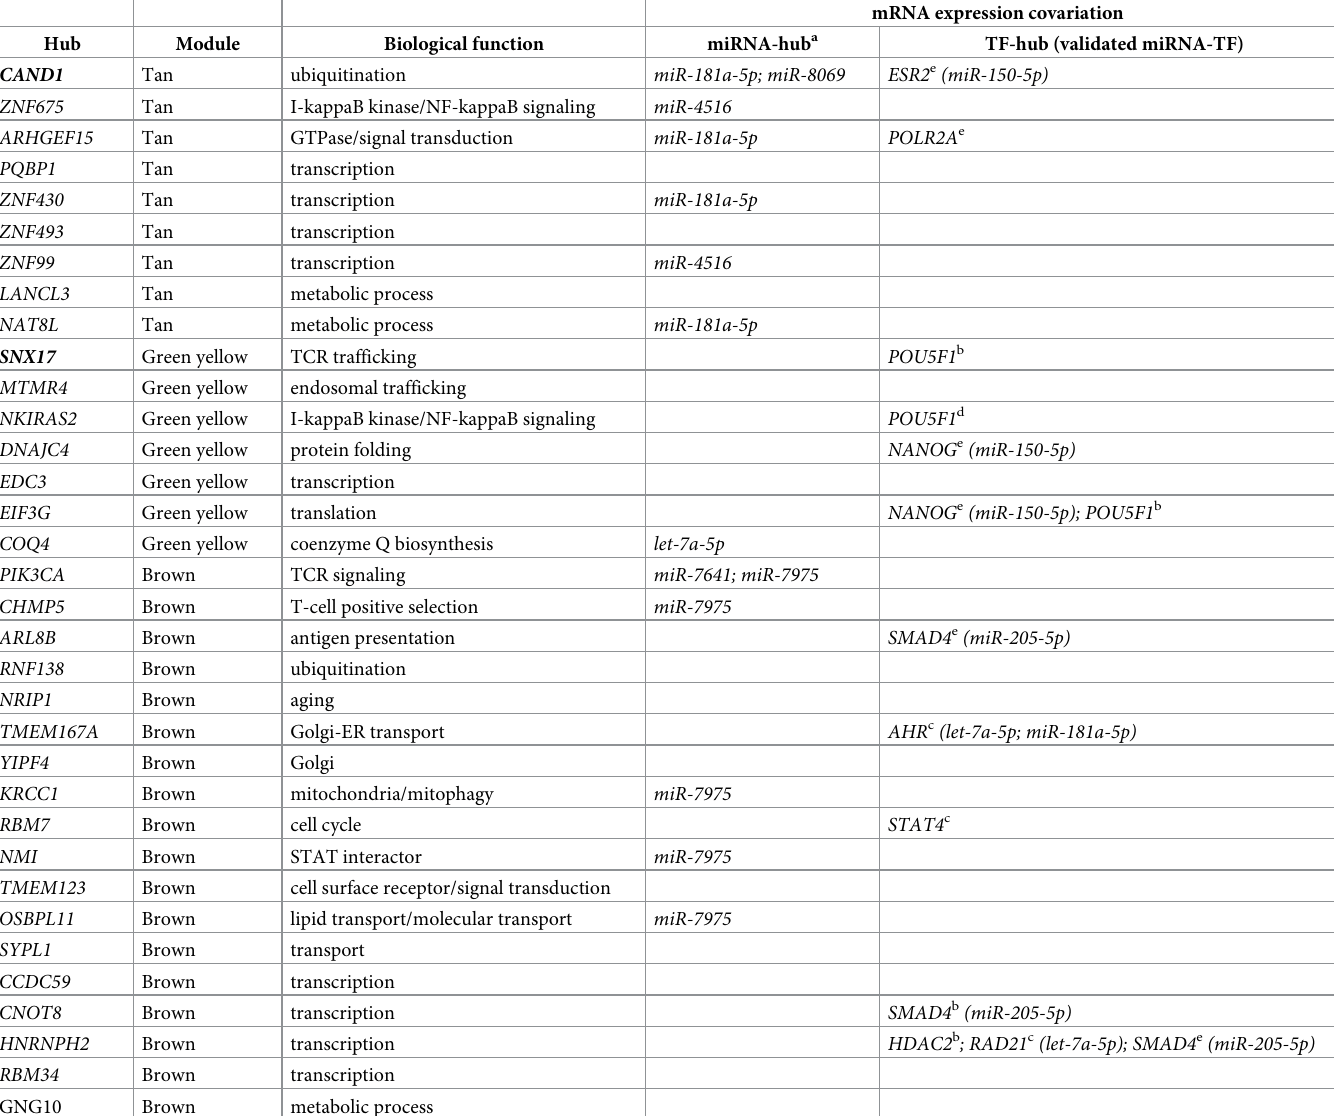
Table 1. Biological functions and TF-miRNA-hub gene co-expression correlations for the hubs found in modules highly associated with age groups.